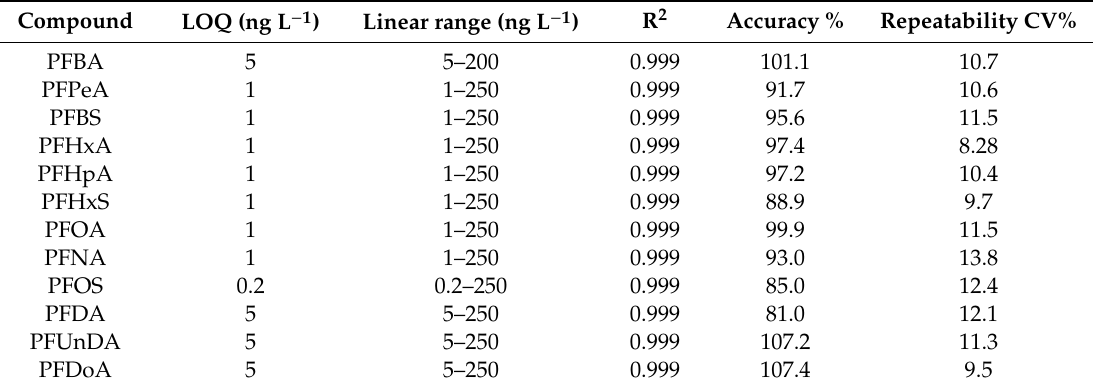
Table 3. Limit of quantification (LOQs), linearity range, R 2 , Accuracy, and Repeatability parameters evaluated at